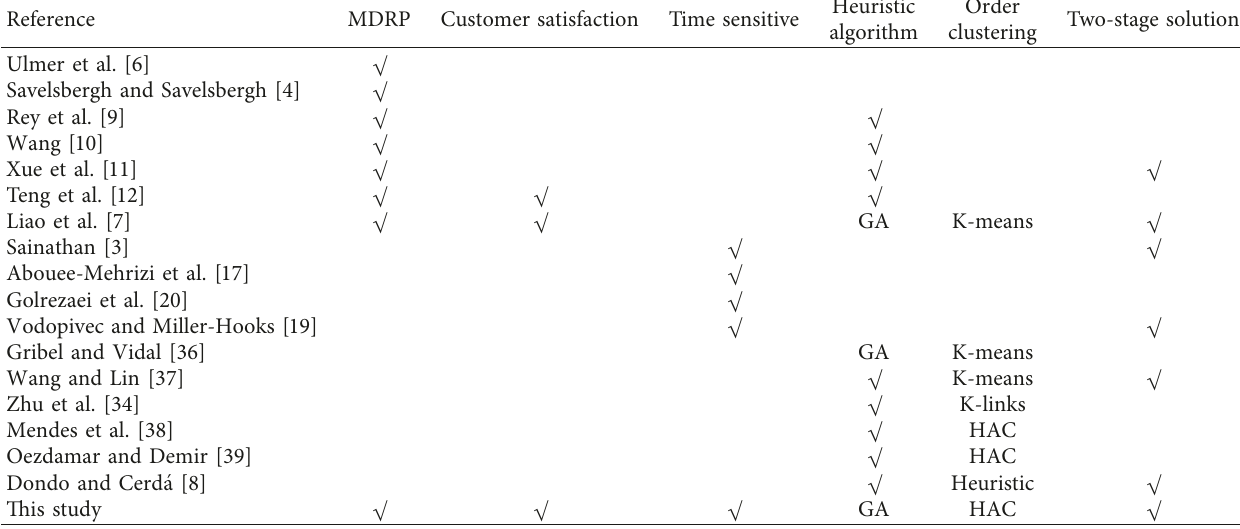
Table 1: Comparison between the existing literature and this study.